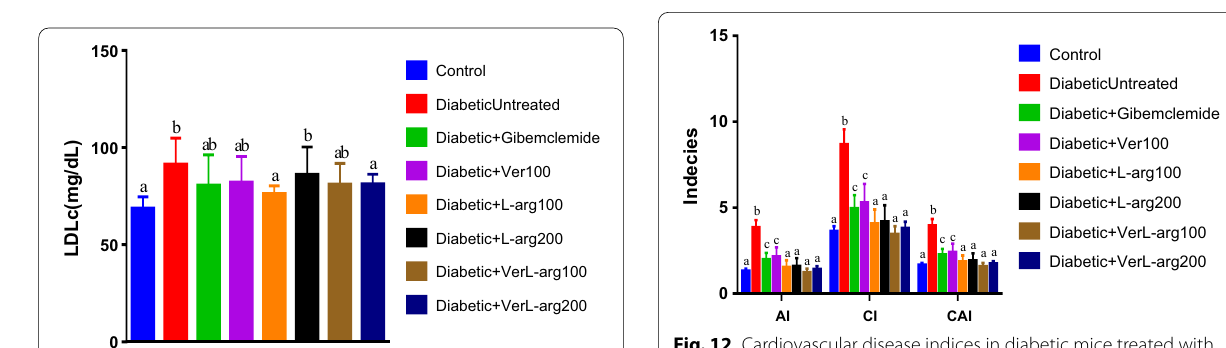
Fig. 12 Cardiovascular disease indices in diabetic mice treated with verbenone, L-arginine and ratios of verbenone L-arginine (1:1 v/m) + after 14 days treatment. Values are expressed as mean SEM, n 5. ± = Values with different superscripts are significantly different at p < 0.05. AI Atherogenic index, C.I Cardiac index and C.A.I Coronary = = = Artery index, VerL-arg verbenone L-arginine (1:1 = +